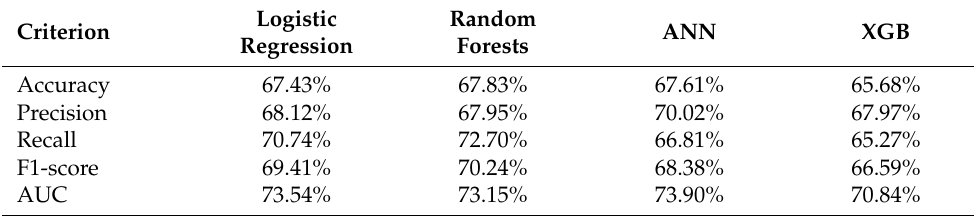
Table 4. The correct classification metrics for each machine learning